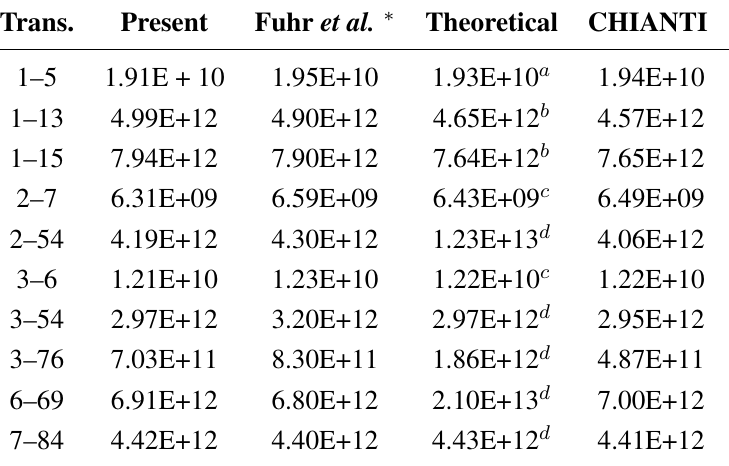
Table 5. Comparison between the present calculations of transition probabilities ( A and other references. Trans. Present Fuhr et al. ∗ Theoretical